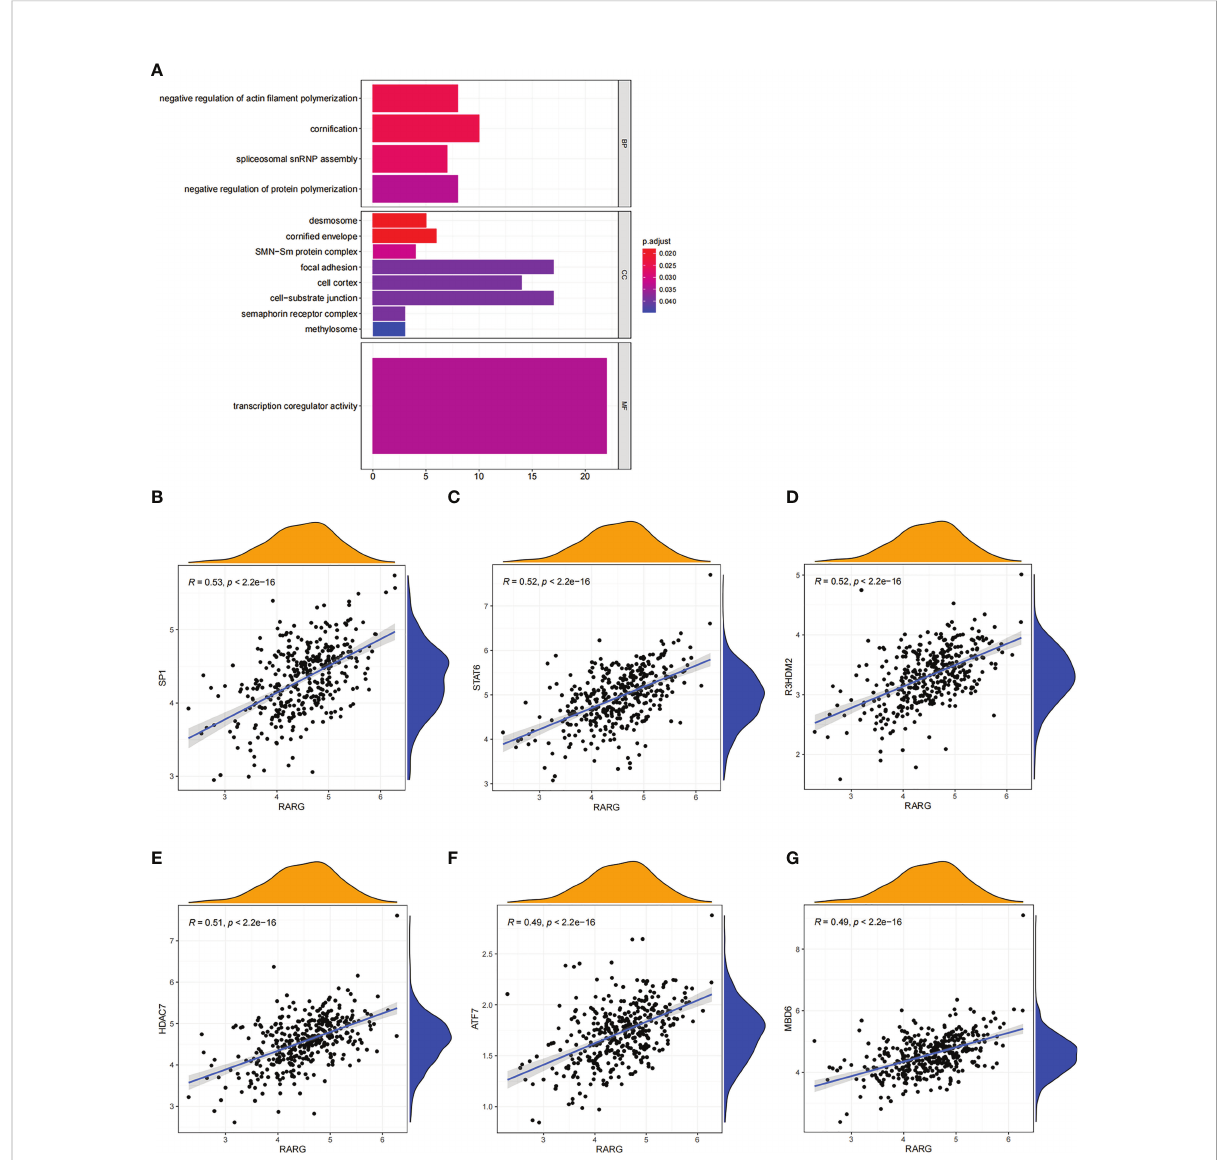
FIGURE 4 GO enrichment analysis of RARG related genes. (A) The results of GO enrichment analysis of RARG related genes were shown in a bubble chart: molecular function (MF), biological process (BP), and cellular component (CC). (B – G) RARG was signi fi cantly correlated with SP1 (B) , STAT6 (C) , R3HDM2 (D) , HDAC7 (E) , ATF7 (F) and M8D6 (G)